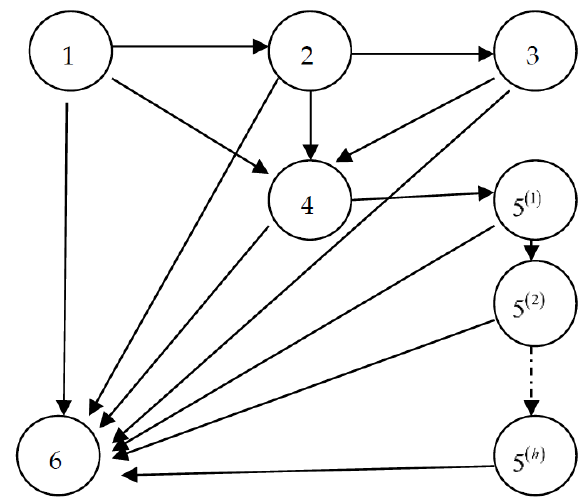
Figure 1. The multistate model for one spouse.